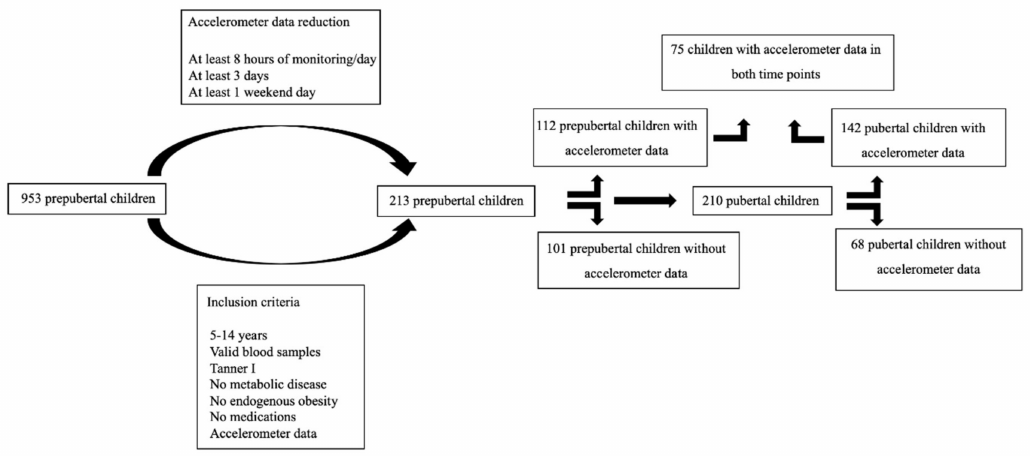
Figure 1. Design of the